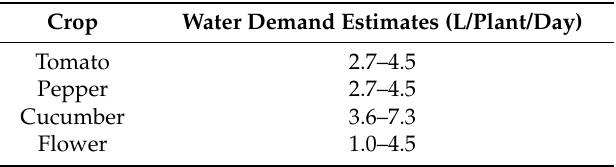
Table 1. Current crop water demand